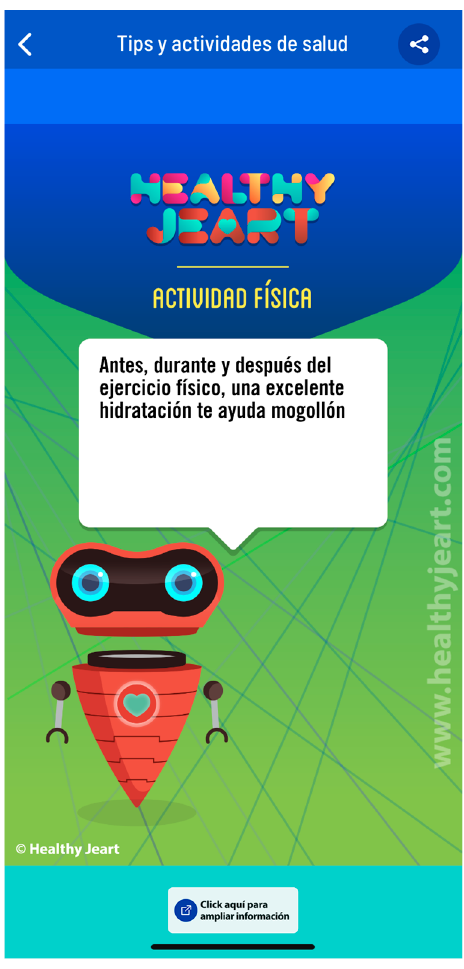
Figure 4. Healthy tips and didactic resources. “Before, during and after physical exercise, an excellent hydration helps you a lot”. hydration helps you a